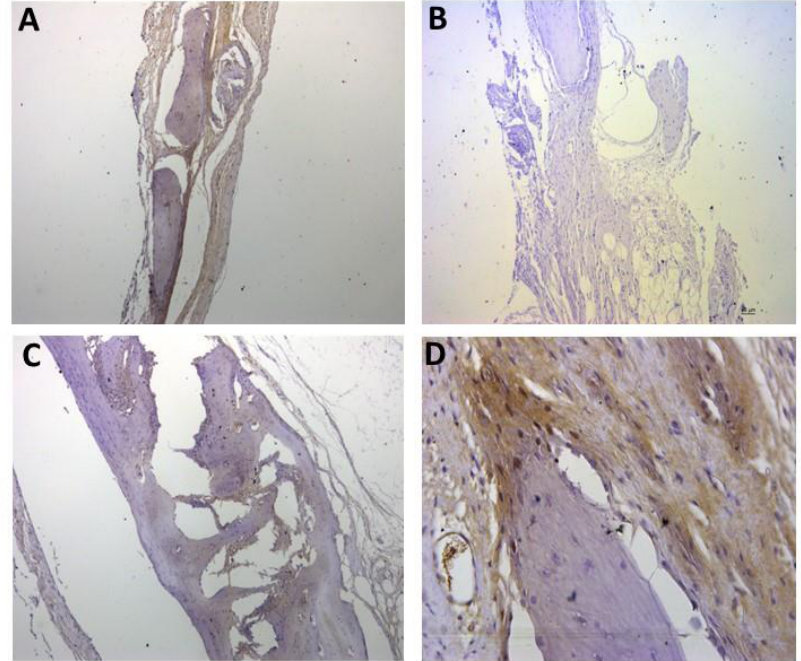
Figure 10. Representative immunohistochemistry images for RUNX2 staining. ( A ) control group; ( B ) negative control; ( C ) group 2 with marking considered (+); ( D ) group 3 with marking considered (++); the most observed staining pattern among the groups analyzed. Harris’ hematoxylin counterstained. Scale bar: 46 µm.